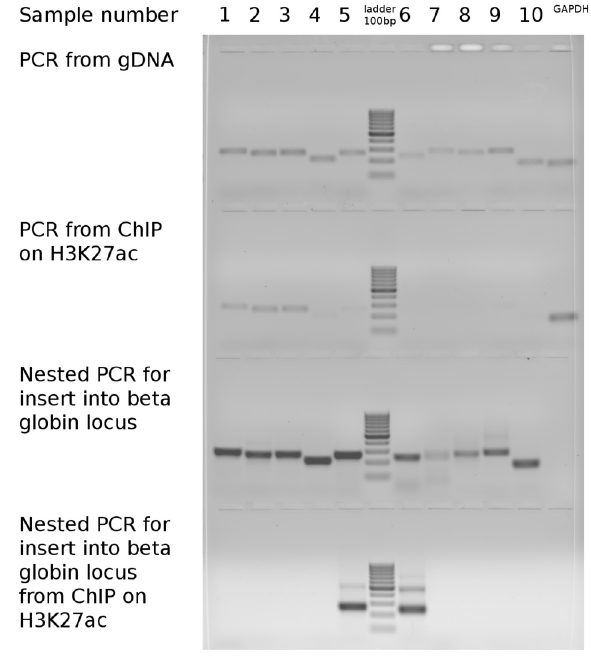
Figure 1. Amplification of chosen sequences in native and foreign genomic context; H3K27ac ChIP-PCR in native and foreign genomic